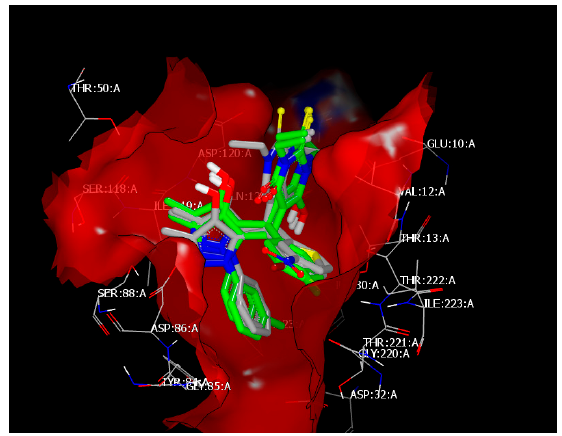
Figure 5. Visual representation of 4a overlay with 4o , 4d , 4g , and 4i , showing the hydrophobic– hydrophobic interaction at the binding site of 3Q70, as shown by Vida.